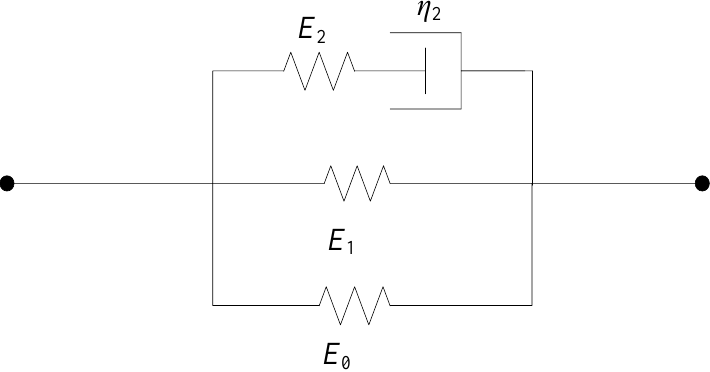
Figure 2. The “Zhu–Wang–Tang” model simplified.